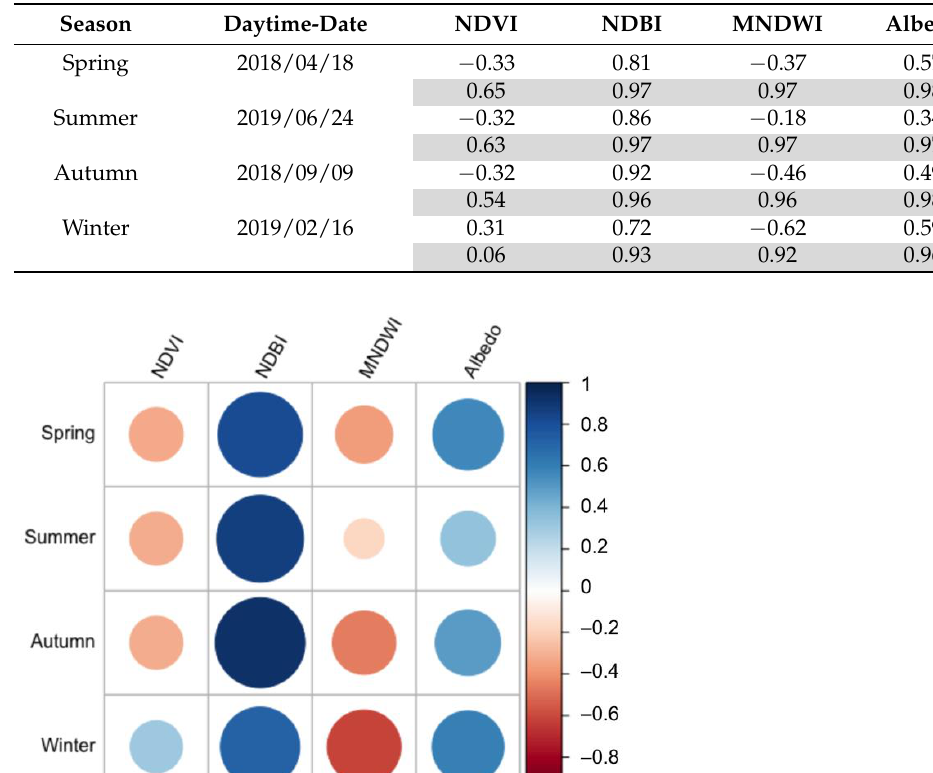
Table 5. The relationship between the selected land cover indices and LST by Pearson correlation coefficient (white lines) and OSL coefficient of determination (gray lines).